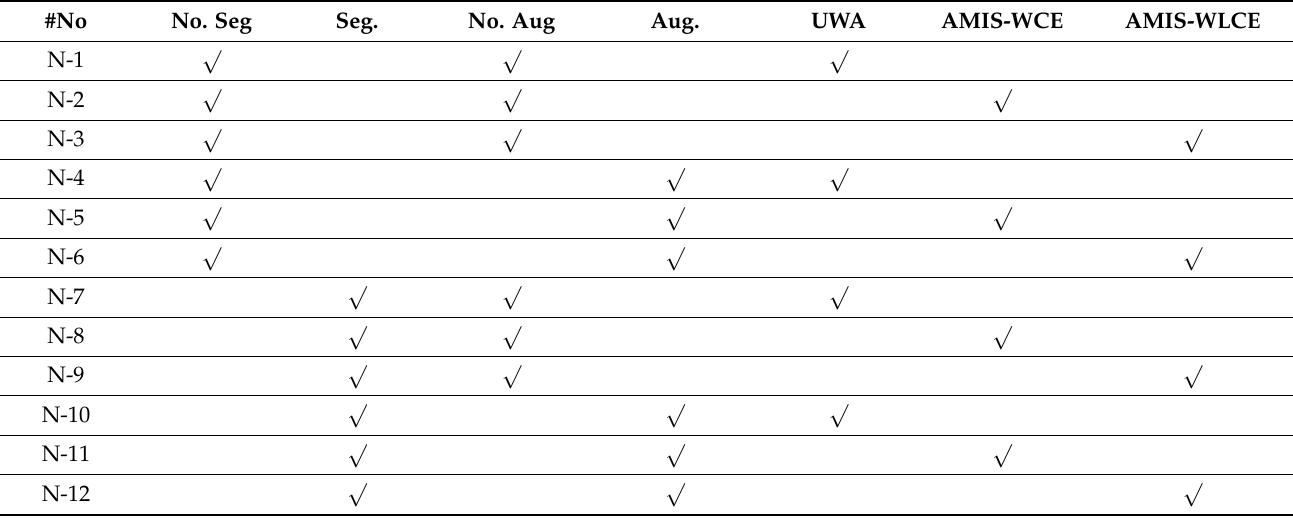
Table 16. Combination of different methods used in ensemble deep